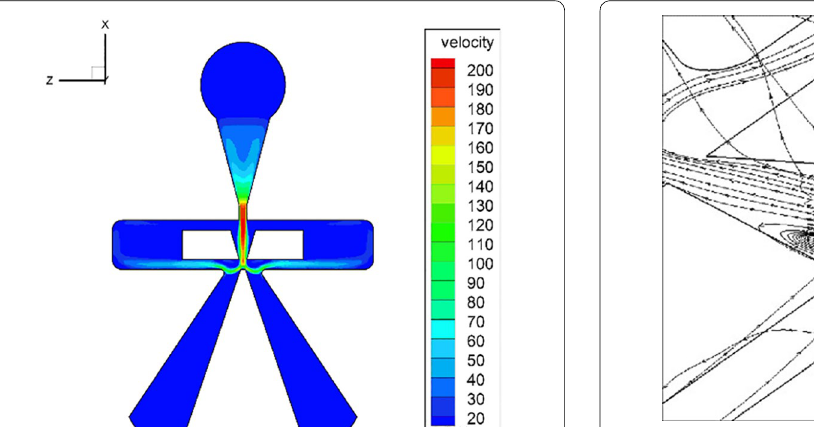
Figure 19 Spiral flow in the deflector